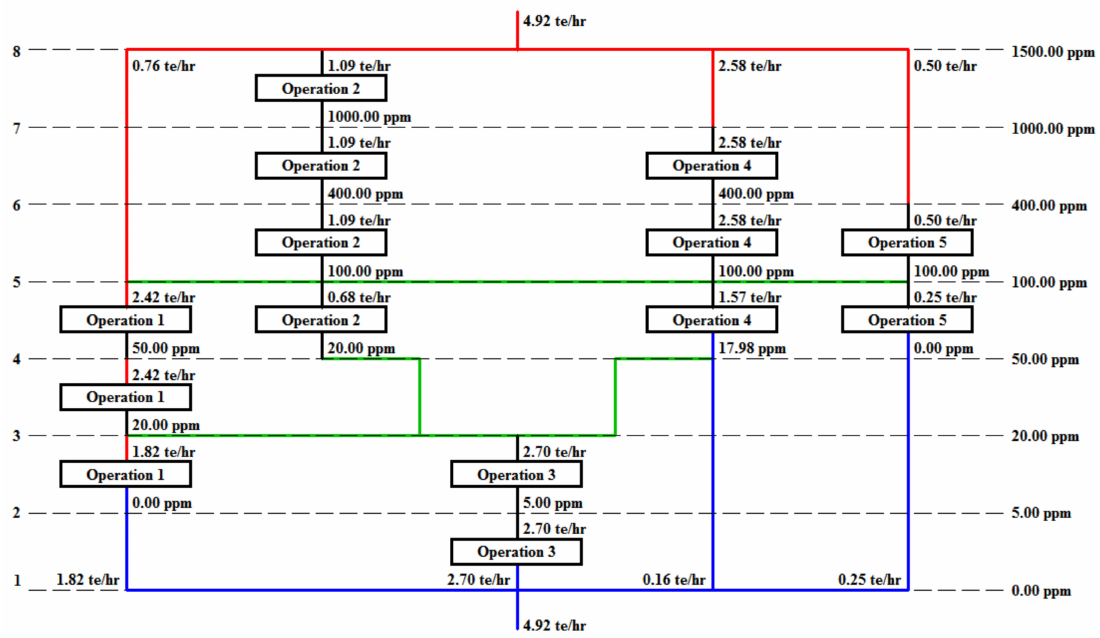
Figure 5. Preliminary block diagram concentration-interval boundaries. The blue, green, and red lines represent fresh water, water reuse, and effluent streams,